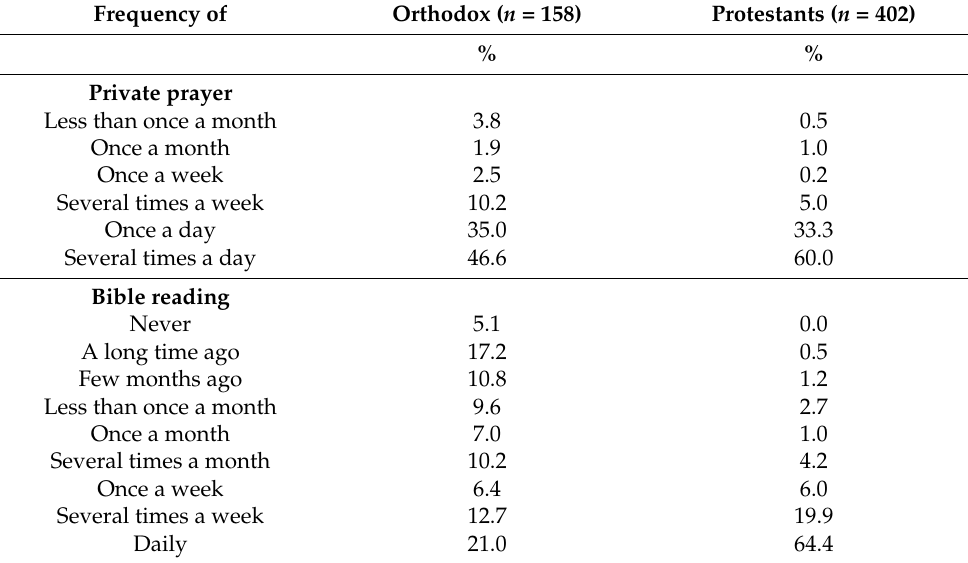
Table 2. Participant religious behaviour ( n =